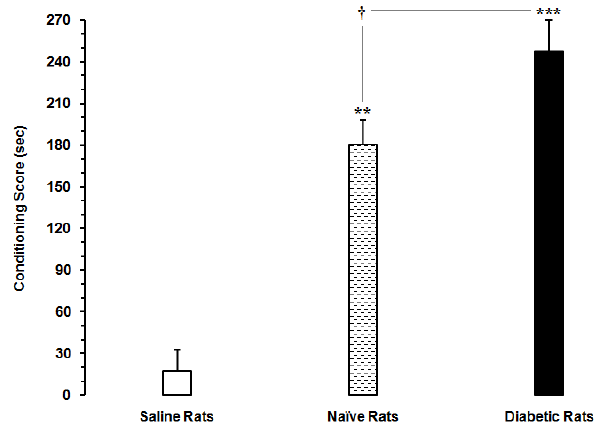
FIGURE 3 - Effect of STZ-induced diabetes on the acquisition of morphine-induced place preference (relevant to Figure 1A). Animals received saline (1 ml/kg) or morphine (5